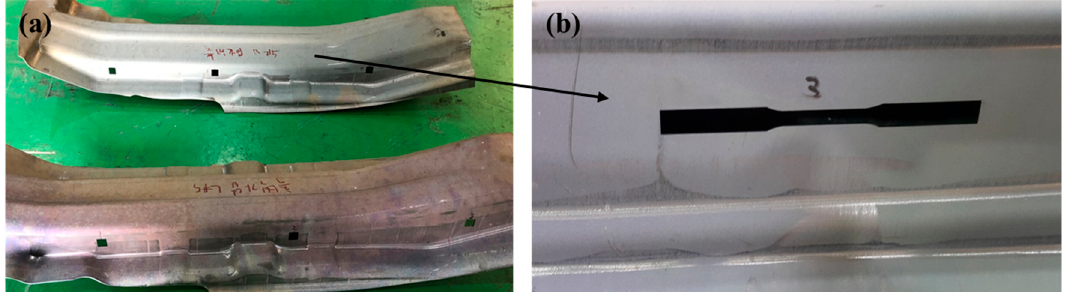
Figure 6. ( a ) Blank manufactured by the HPF (Hot Press Forming) process; ( b ) Tensile test specimen from the blank.